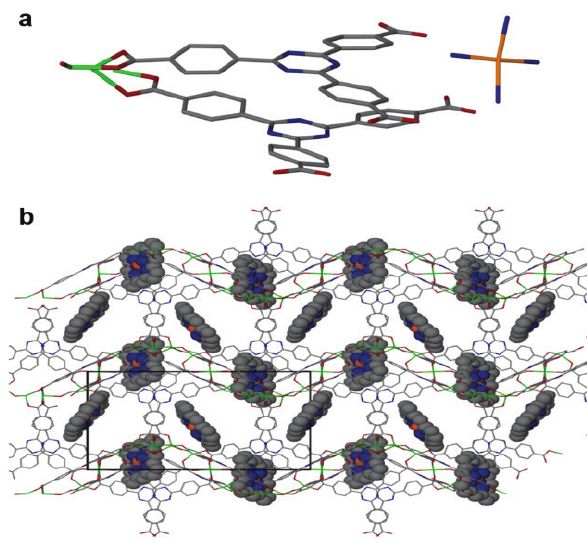
Figure 19 : Crystal structure of Fe(III)PPIX@ 1 . (a): Coordination environment of the asymmetric unit of Fe(III)PPIX@1 showing the located Fe and N atoms of Fe(III)PPIX in 1 and (b) packing of Fe(III) PPIX@1 viewed along the b-axis with a rigid-body model of the porphine core of Fe(III)PPIX in the channels of the framework (shown as space-fill; orange = Fe, blue = nitrogen) [128]. Reprinted with permission from Ref. [128]. Copyright © 2018, American Chemical